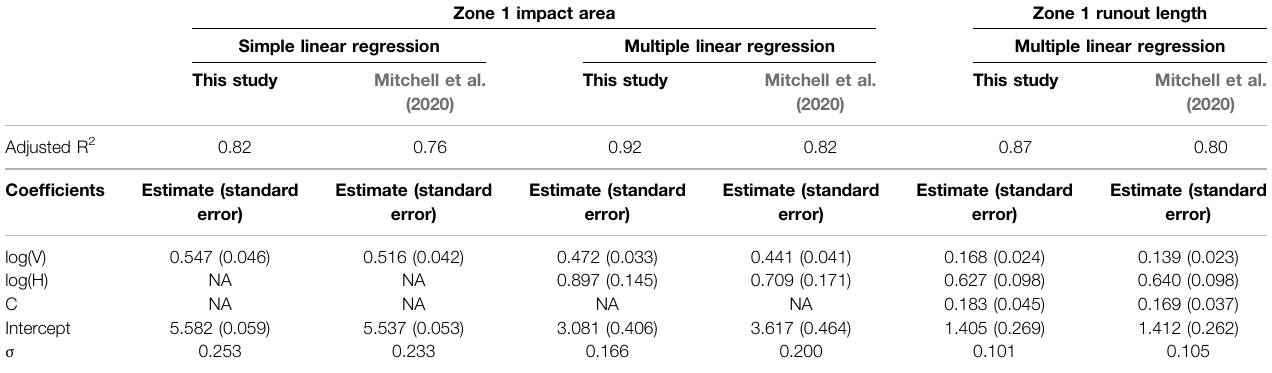
TABLE 3 | Regression summary for Zone 1 impact area and runout and comparison to the estimates from Mitchell et al.